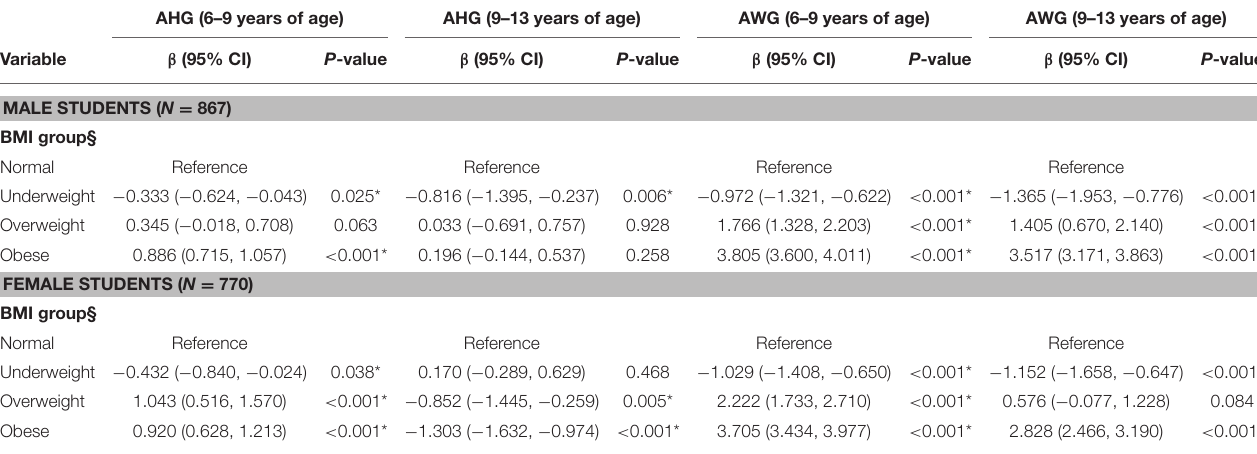
TABLE 2 | Factors associated with height gain and weight gain.